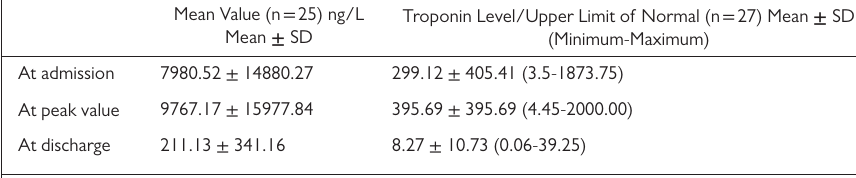
Table 1. Mean Troponin I Levels at Admission, at Peak Value, and at